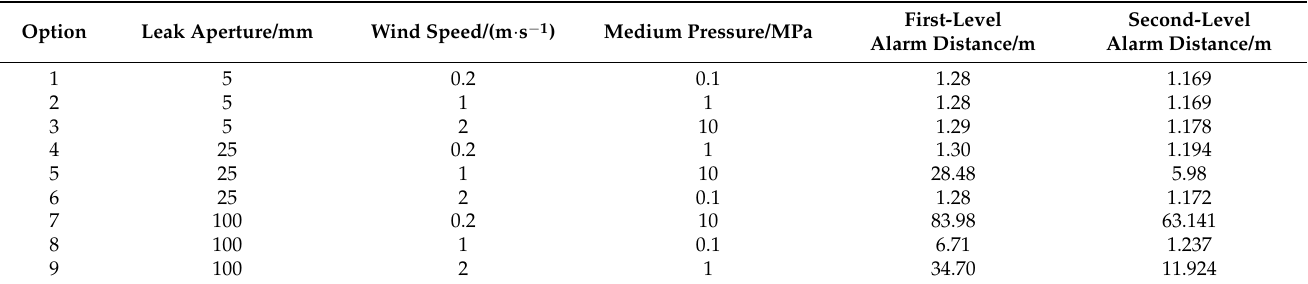
Table 1. Orthogonal design calculation scheme and results.